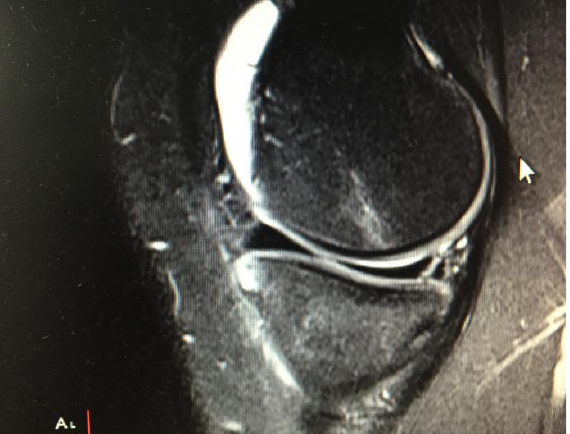
Figure 1. Magnetic resonance (MR) sagittal view of a right knee in 20-year-old male patient with a longitudinal meniscal tear in posterior part of medial meniscus.